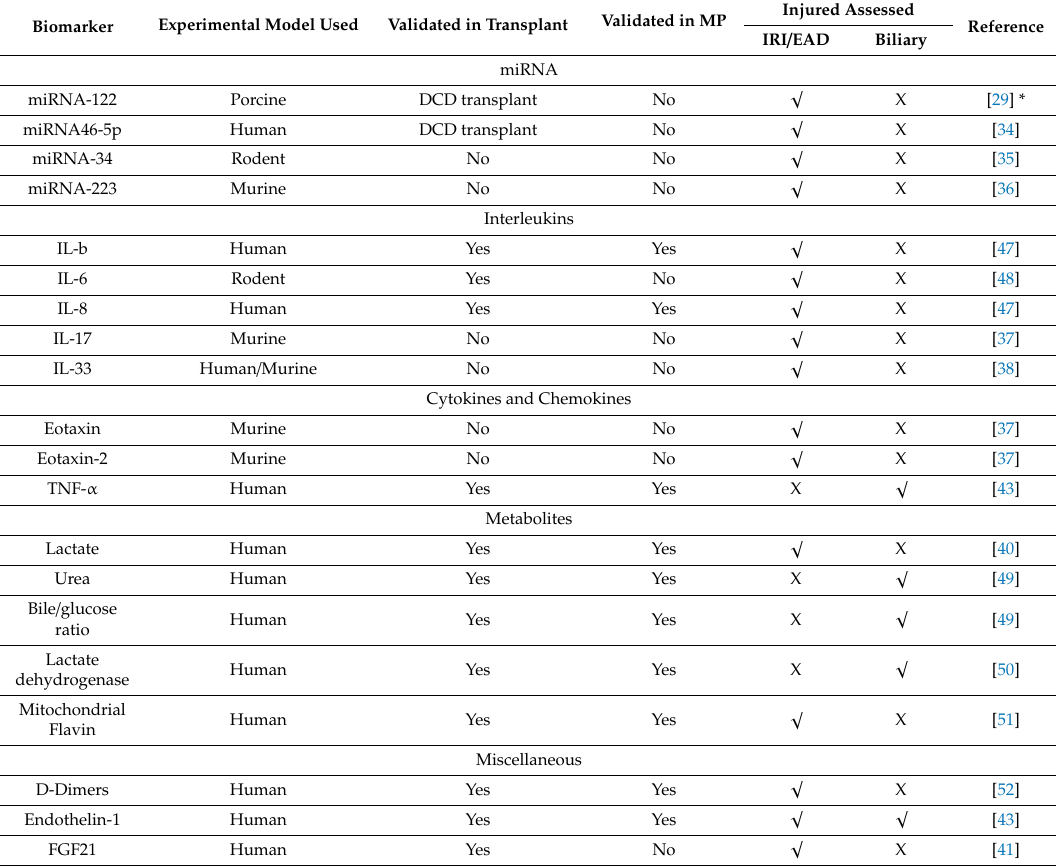
Table 1. Summary of pre-clinical, transplant-related and machine perfusion-related biomarkers of the liver ischaemia reperfusion